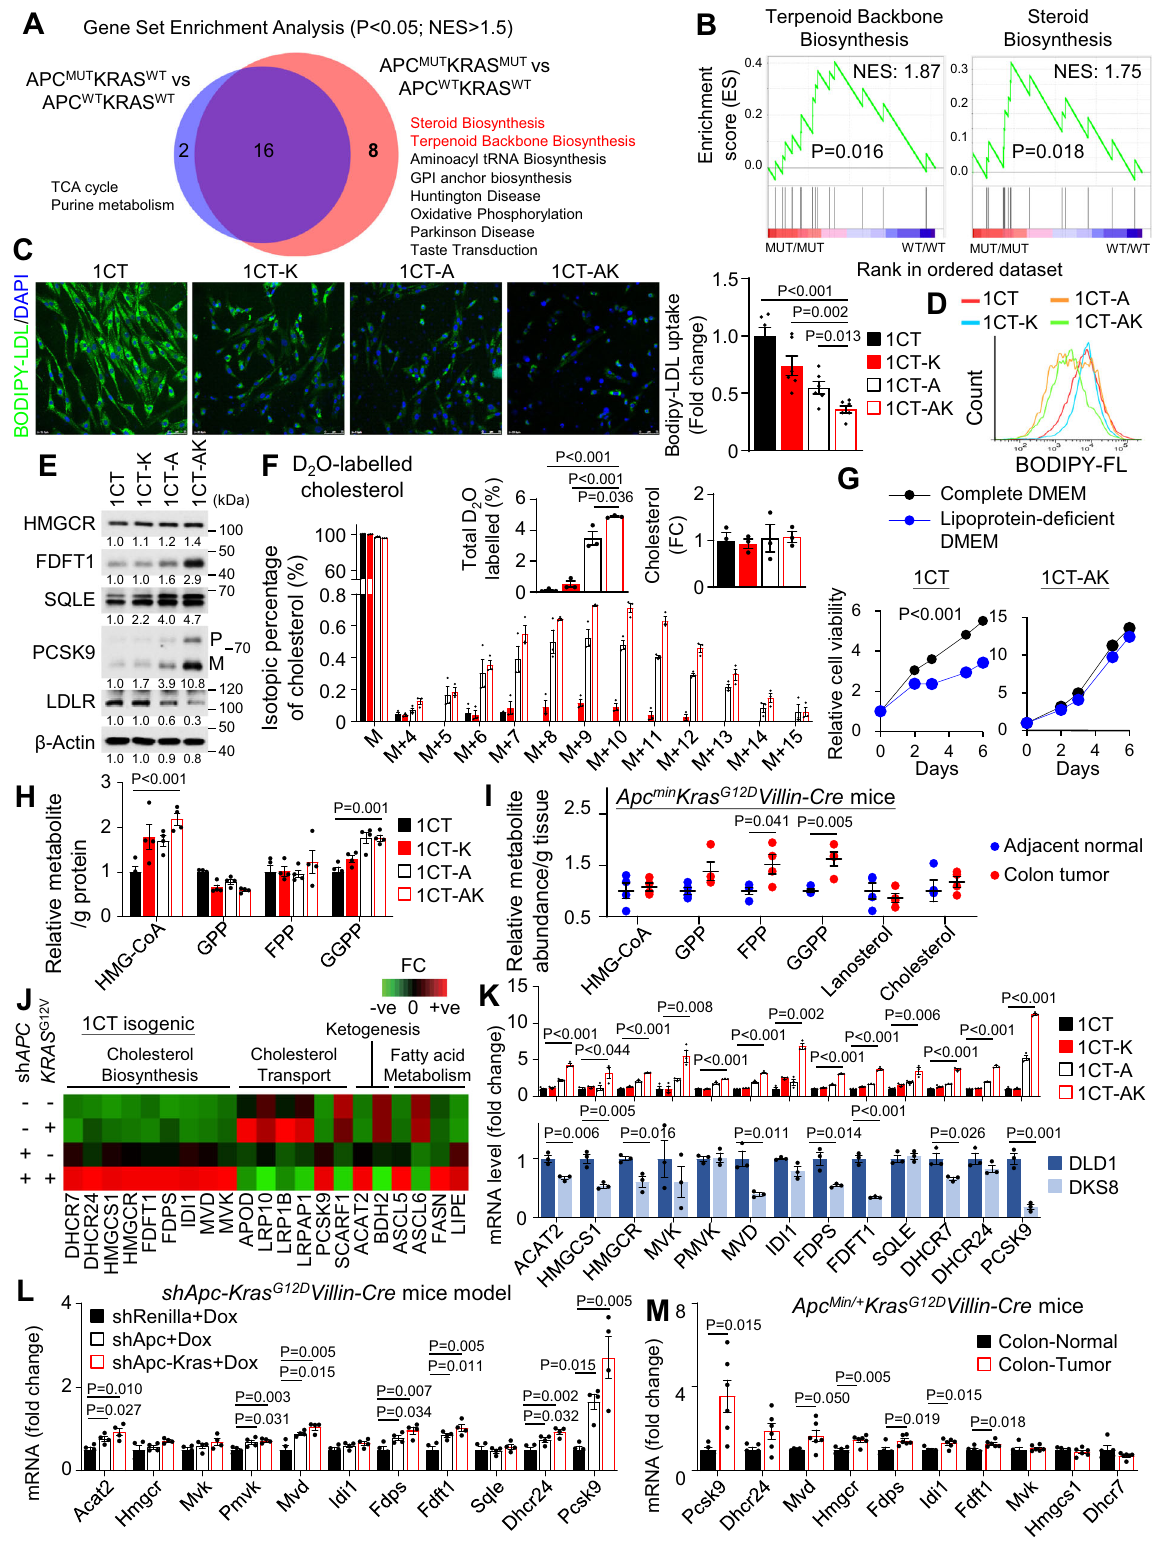
reduced mRNA levels of PCSK9 and cholesterol biosynthesis genes (Fig. 1K). Western blot of 1CT isogenic cells con fi rmed the up-regulation of PCSK9, FDFT1 and SQLE in 1CT-AK cells (Fig. 1E). We also evaluated the effect of APC -loss and Kras G12D on cholesterol metabolism-related gene expression in genetic CRC mice models (sh Renilla , sh Apc and sh Apc-Kras G12D